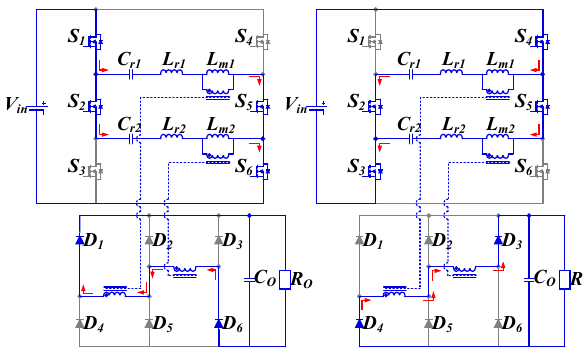
Figure 10. Current path of Switching Pattern 5.